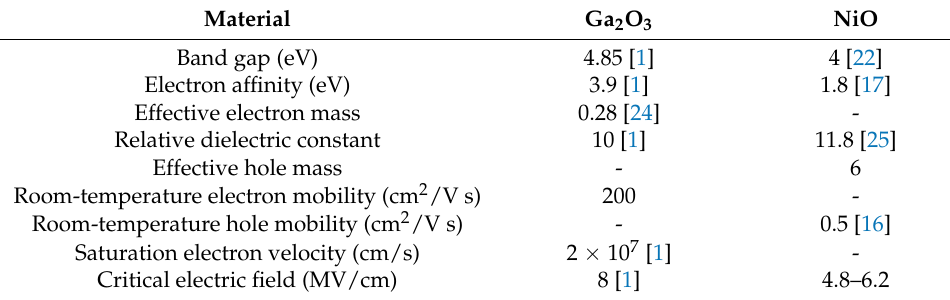
Table 1. Material parameters used for simulation.